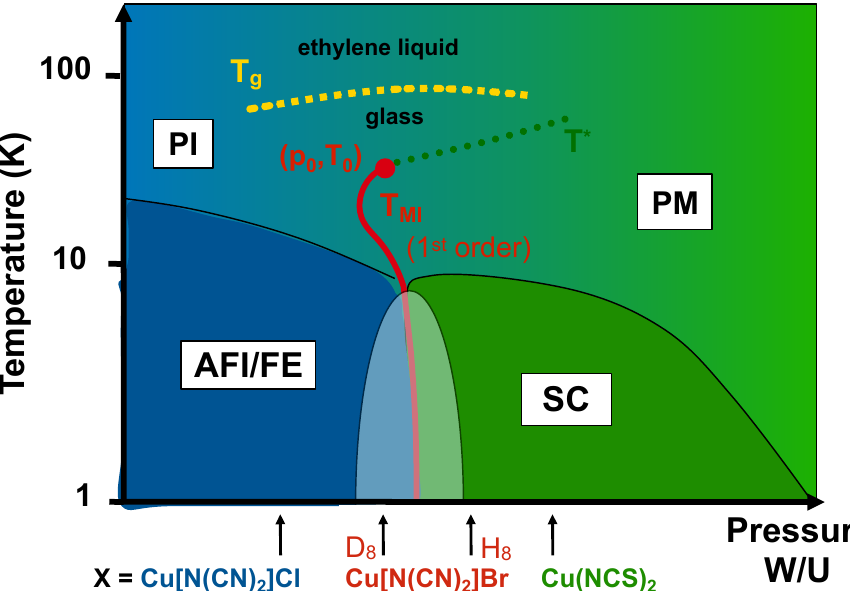
Figure 2. Schematic temperature–pressure phase diagram of the κ -(BEDT-TTF) 2 X salts with polymeric anions, after Refs. [17–21]. Indicated is the position of systems with different anions X at ambient pressure. Hydrostatic pressure can be mapped on an increasing ratio of W / U (see text). PI, PM, AFI, FE and SC stand for the paramagnetic insulating, paramagnetic metallic, antiferromagnetic insulating, ferroelectric and superconducting phase, respectively. The red line marks the first-order Mott metal-insulator transition, which terminates in a finite-temperature critical point. At elevated temperatures, a structural glass-like transition of the ET molecules’ ethylene endgroup rotational degrees of freedom occurs (dashed yellow line). The green dotted line marks the crossover to an anomalous metallic (’bad metal’) phase above the Fermi